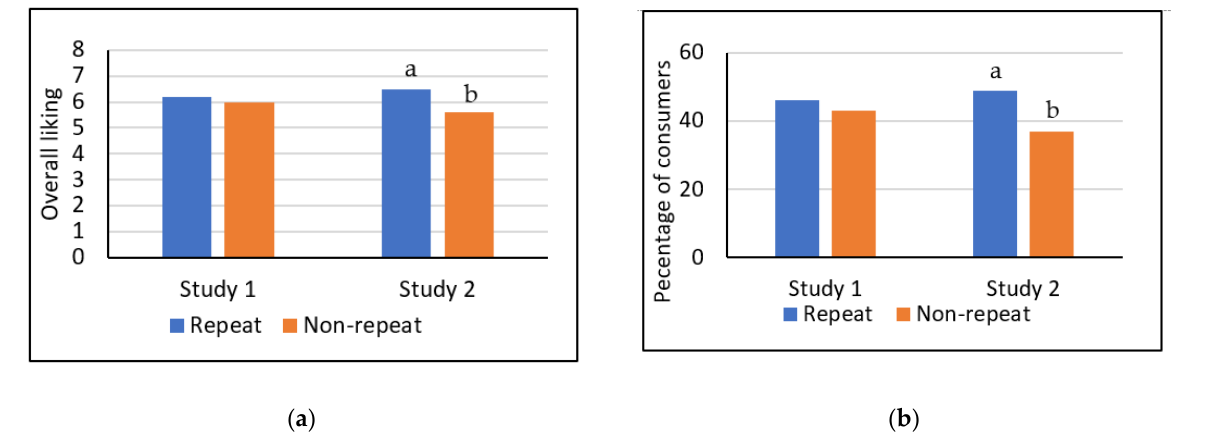
Figure 1. ( a ) Mean overall liking scores (a 9-point hedonic scale) and ( b ) positive purchase intent (PI) for CSC, comparing repeat-exposure consumers (participated in both Study 1 and Study 2; N = 25) to those testing CSC for the first time (participated in only Study 1 or Study 2, N = 90 for each study). a,b Different letters indicate a significant difference in OL/PI based on two-sample t-test/chi-square test ( α =